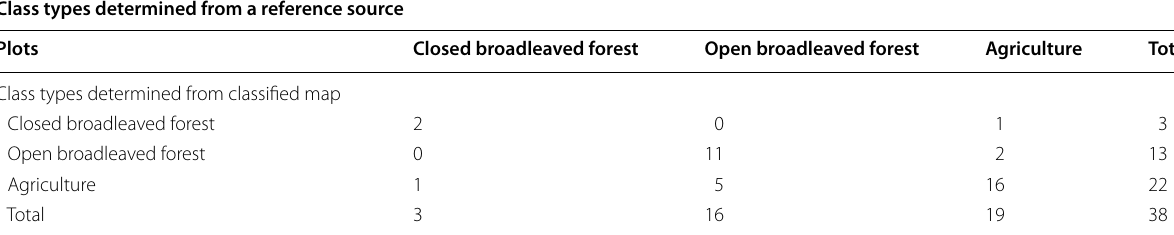
Table 5 Summarisation using error matrix Class types determined from a reference source Plots